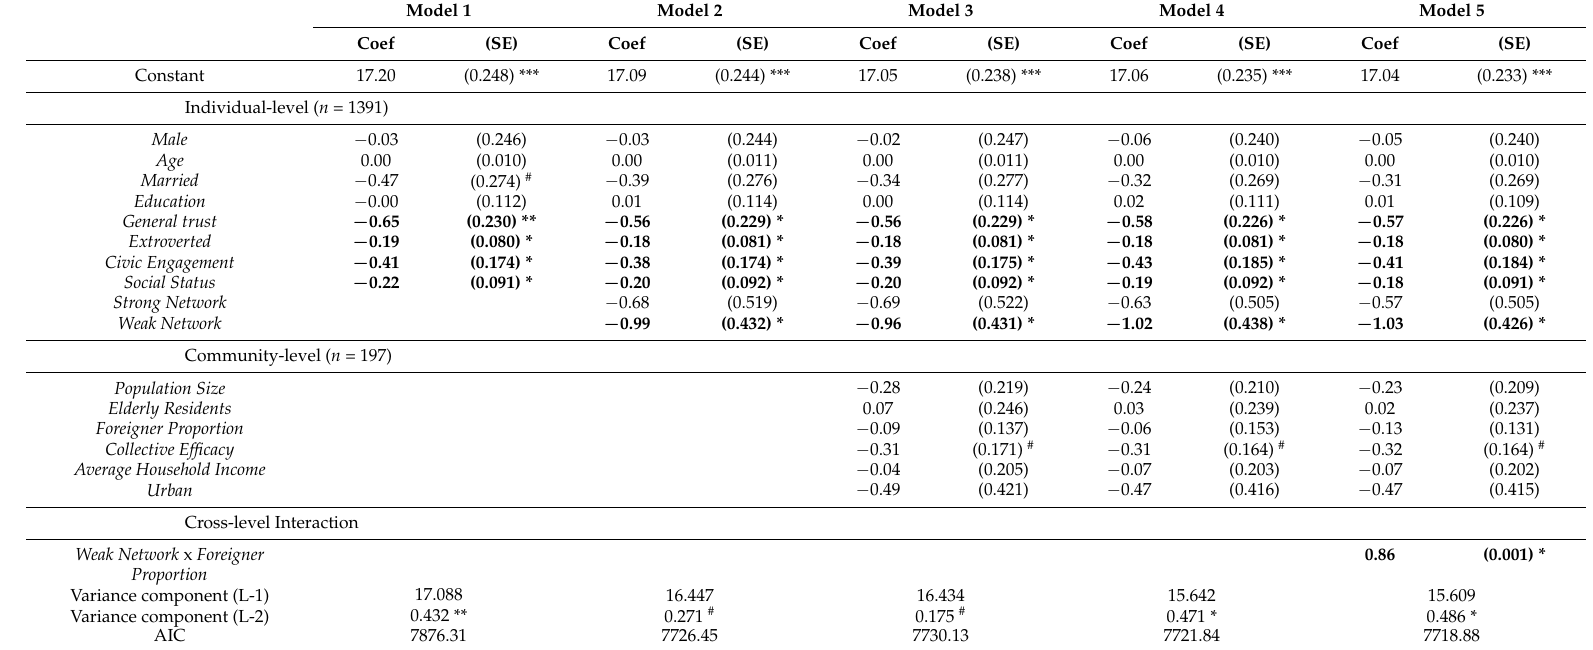
Table 2. Results from multilevel models predicting depressive symptoms among Korean adults (Kim